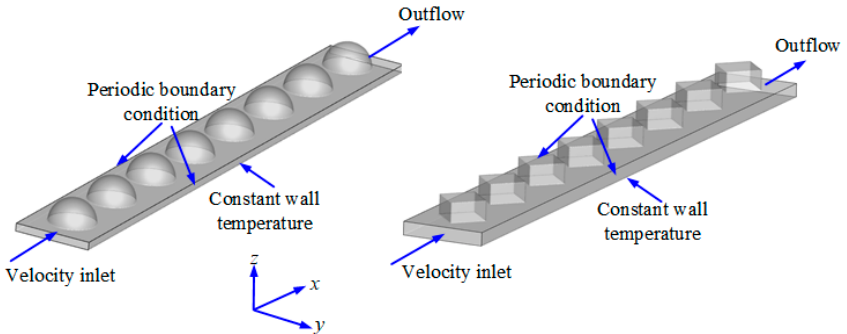
Figure 2. A dimpled channel model with boundary conditions.